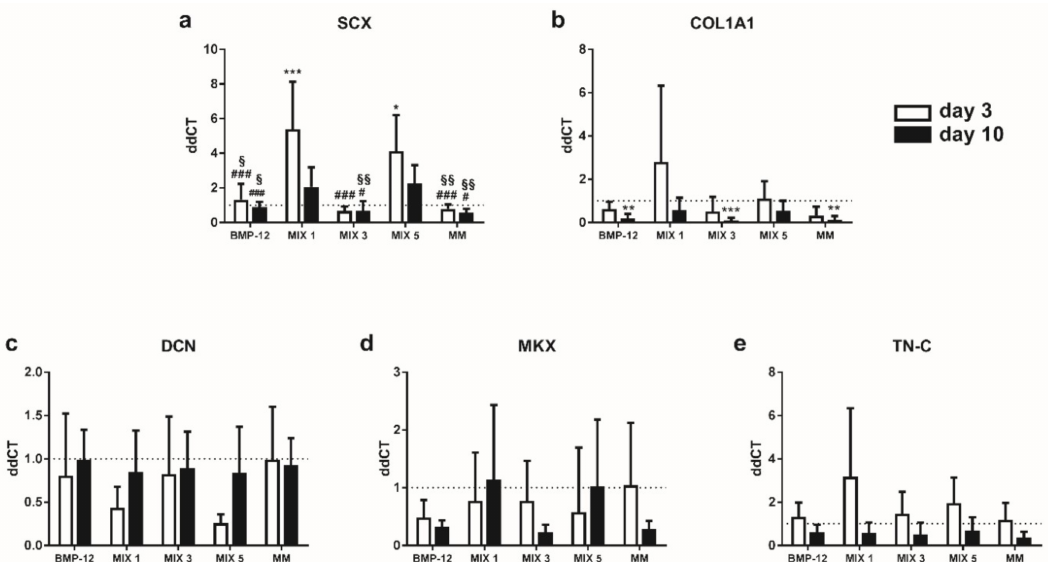
Figure 5. Expression of tendon-specific markers by BMSCs at 3 and 10 days after tenogenic induction. Expression levels of ( a ) SCX ; ( b ) COL1A1 ; ( c ) DCN ; ( d ) MKX ; ( e ) TN-C in BMSCs after tenogenic induction. Data are expressed as mean ddCT ± SD normalized to YWHAZ and CTRL sample. n = 7. * p < 0.05; ** p < 0.01; *** p < 0.001 vs. CTRL. # p < 0.05; ### p < 0.001 vs. MIX 1. § p < 0.05; §§ p < 0.01 vs. MIX 5.